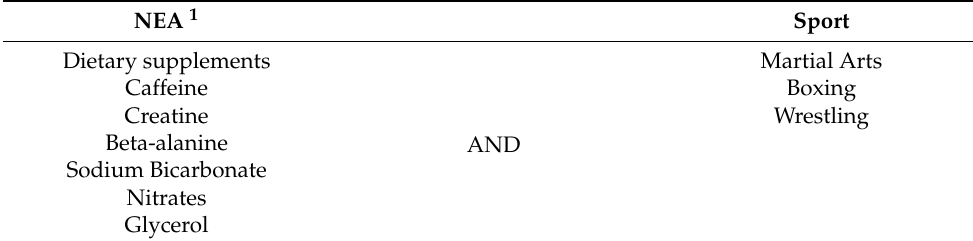
Table 1. Combined Mesh terms used in the search of studies in database. 1 : NEAs filed in group A of AIS. NEA 1 Sport Dietary supplements Martial Arts Caffeine Boxing Creatine Wrestling Beta-alanine AND Sodium Bicarbonate Nitrates